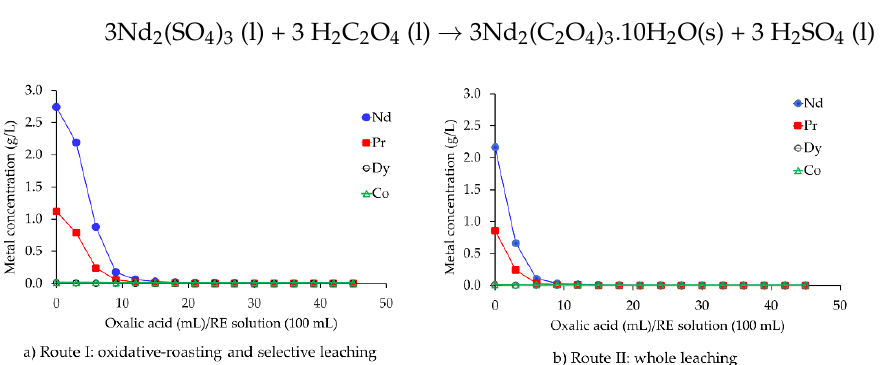
Figure 9. Metal concentration in the rare earth (RE) solution of as-sintered waste after precipitation using oxalic acid for ( a ) route I and ( b ) route II.